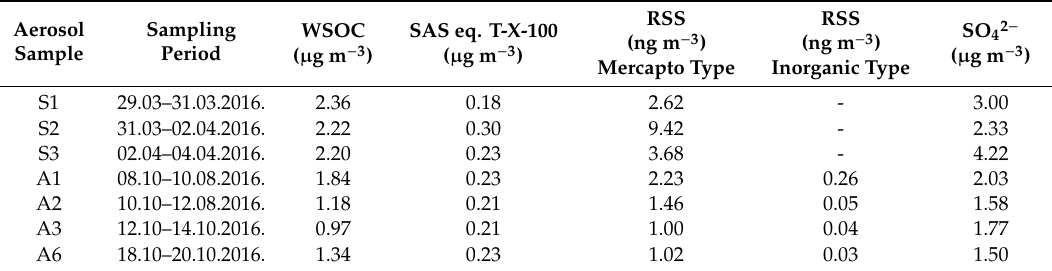
Table 1. Concentrations of reduced sulfur species (RSS), water-soluble organic carbon (WSOC), surface-active substances (SAS), and sulfate (SO 42 − ) in the selected Spring and Autumn 2016 aerosol samples, whose electrochemical characterization is shown in Figure